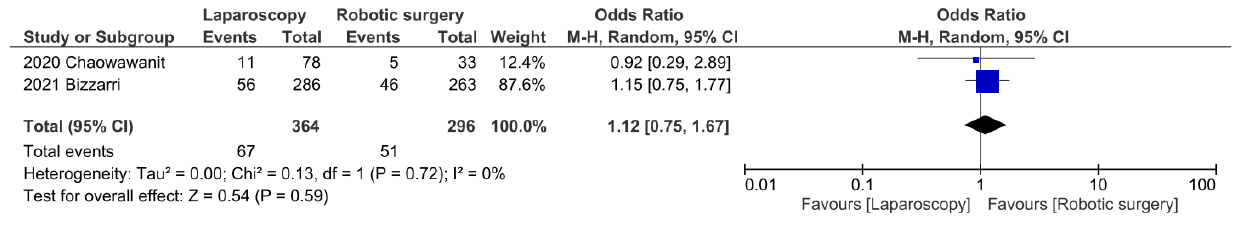
Figure 5. Forest plot of individual and pooled odds ratios, with 95% confidence interval (CI), for unilateral detection, comparing laparoscopy and robotic surgery for SLN biopsy in EC women.